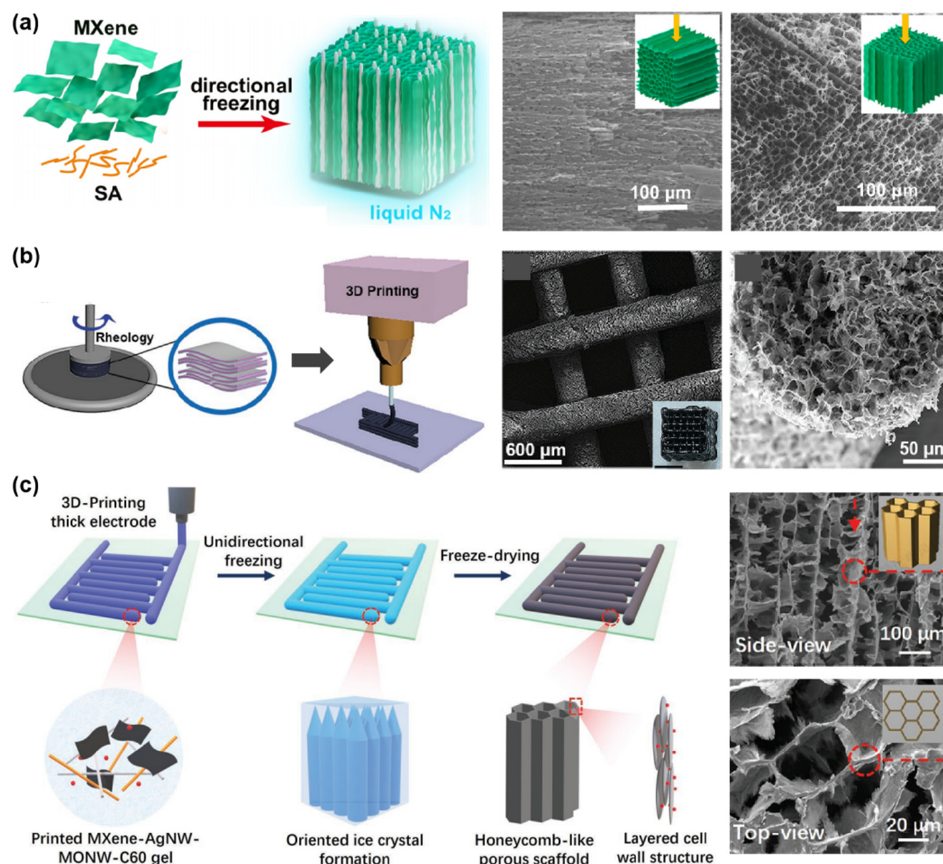
Figure 6. ( a ) Schematic illustration of MXene/SA aerogel with aligned honeycomb microstructure prepared by UFC, and SEM images captured from the side view and top view. ( b ) Schematic illustration showing the 3D-printing MXene architecture, and SEM images showing the MXene architecture and the cross-section of one printed filament. ( c ) Schematic illustration of the MXene architecture prepared by 3D printing and UFC, and SEM images captured from the side view and top view. ( a ) is reproduced with permission from ref. [52]. Copyright 2019, Elsevier. ( b ) is reproduced with permission from ref. [103]. Copyright 2019, Wiley-VCH. ( c ) is reproduced with permission from ref. [109]. Copyright 2020, Wiley-VCH.